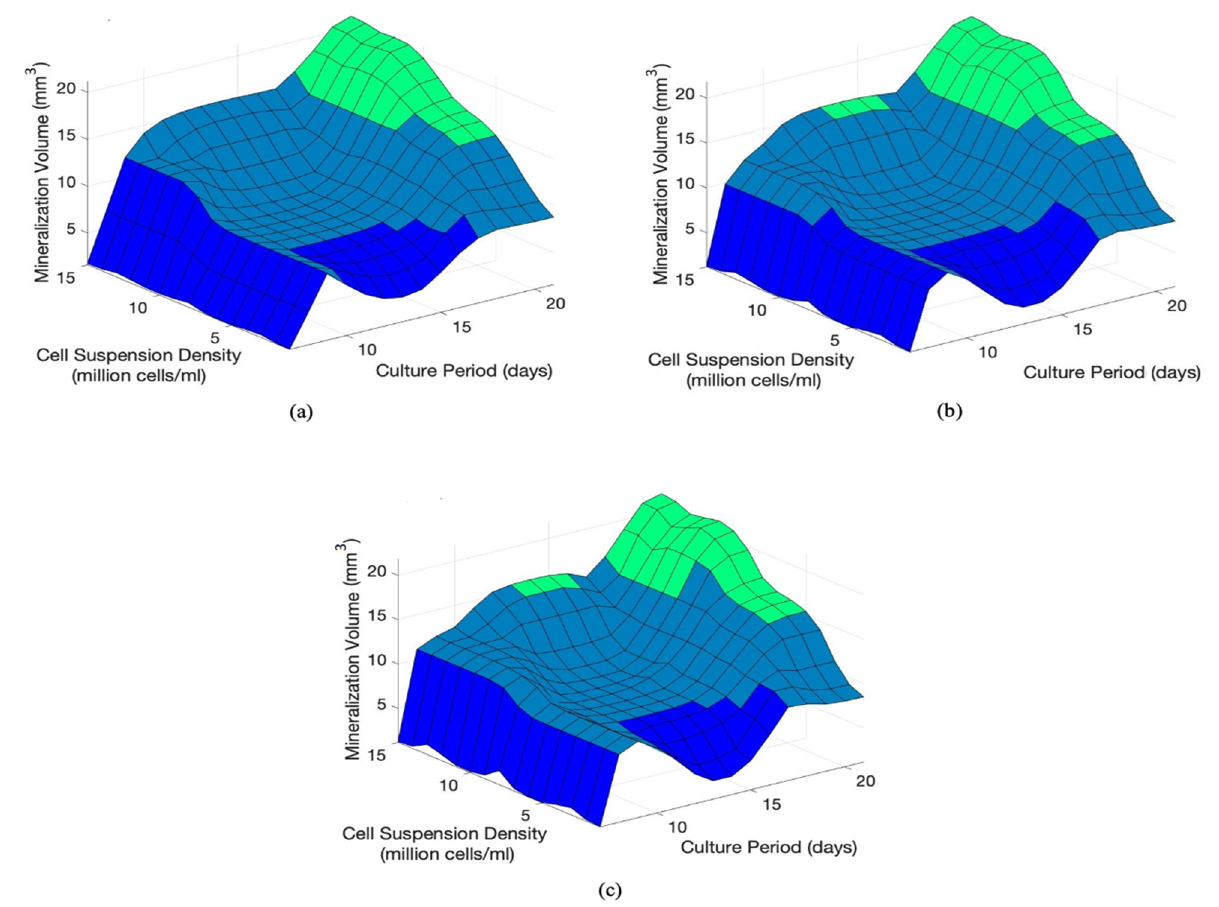
Figure 4. 3D surfaces generated by implemented fuzzy rules. ( a ) Type-1 fuzzy system. ( b ) Type-2 fuzzy system with 20% uncertainty. ( c ) Type-2 fuzzy system with 30% uncertainty.